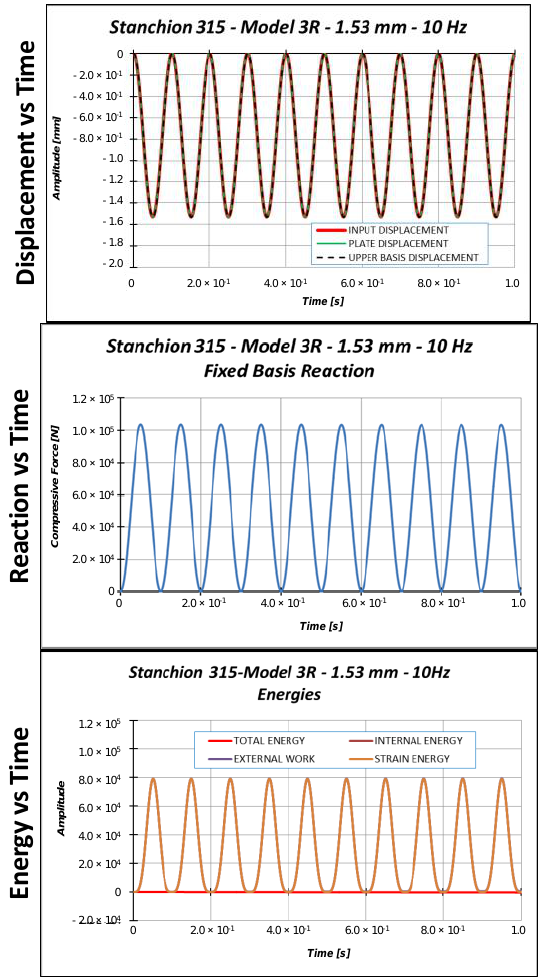
Figure 15. Displacement, reaction, and energies as a function of time: 1.53 mm applied displacement.